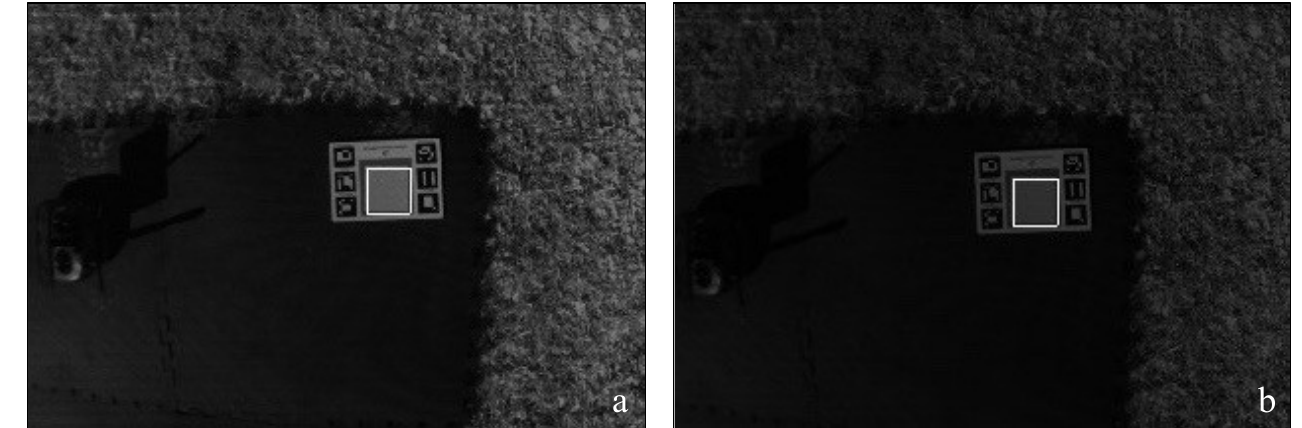
Figure 6. Radiometric calibration plate used to convert raw digital numbers ( a ) to reflectance values ( b ).